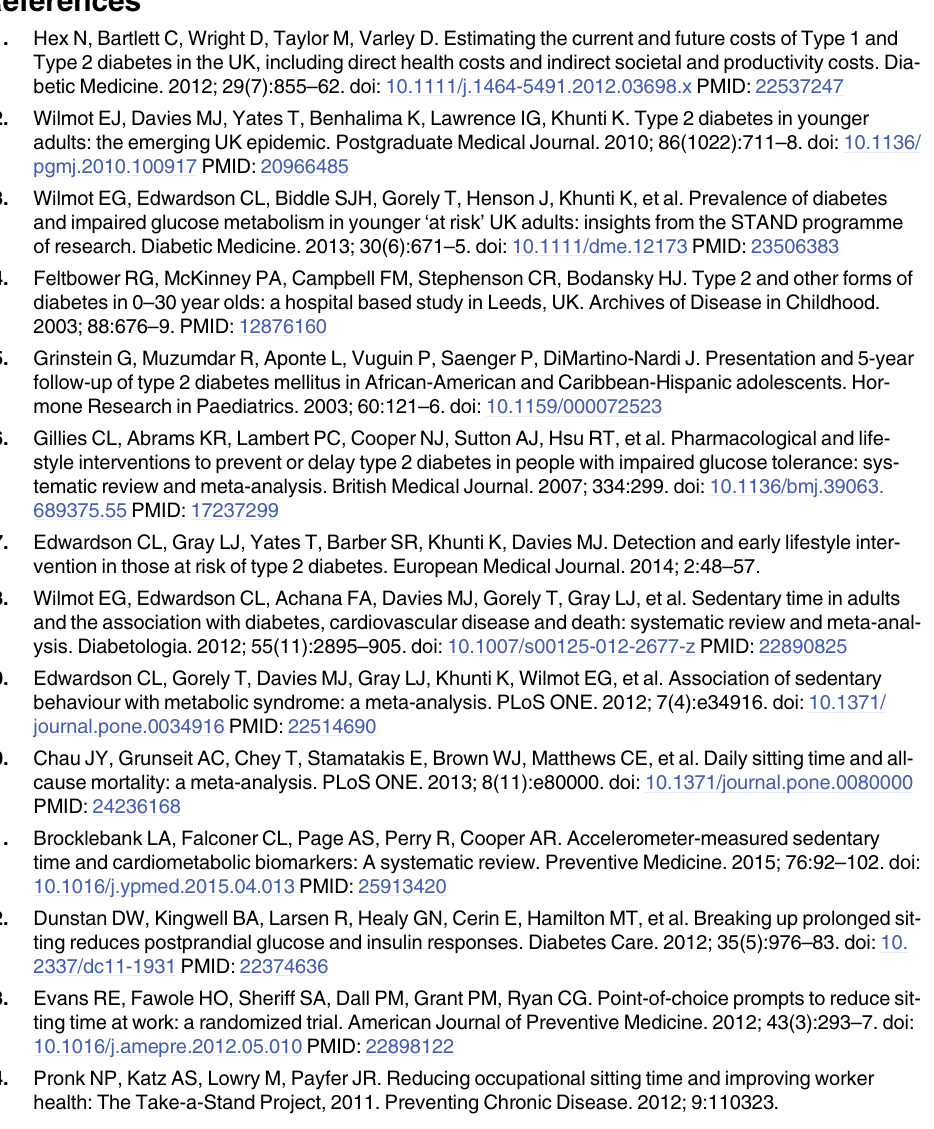
S3 Table. Self-reported sedentary behaviours. S4 Table. Secondary outcomes by randomisation group. S5 Table. Sensitivity